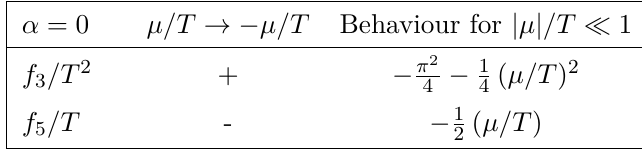
Table 4 . Behaviour at α = 0 of the susceptibilities f 3 , f 5 under a charge conjugation µ → − µ for the vector chemical potential, and polynomial fits for small dimensionless chemical potential | µ | /T (cid:28) 1